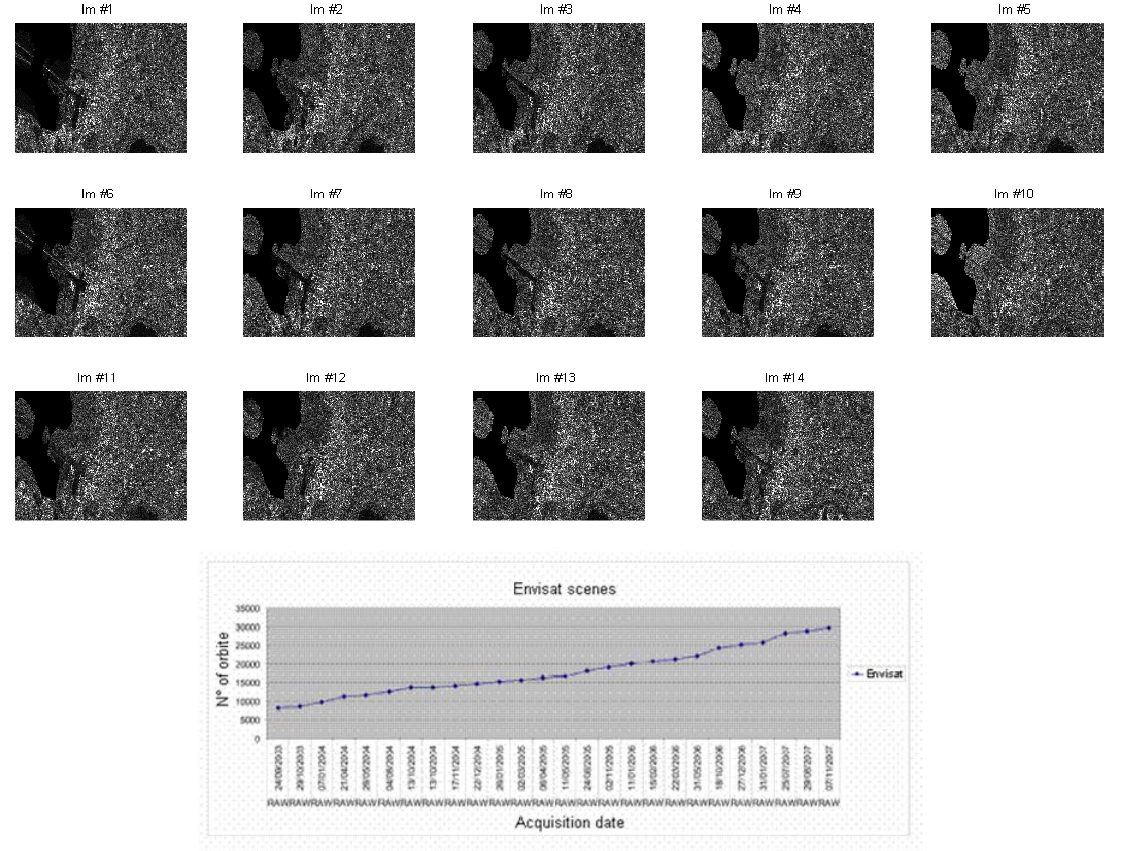
Figure 7. Original SAR Images time series and the corresponding temporal covering.